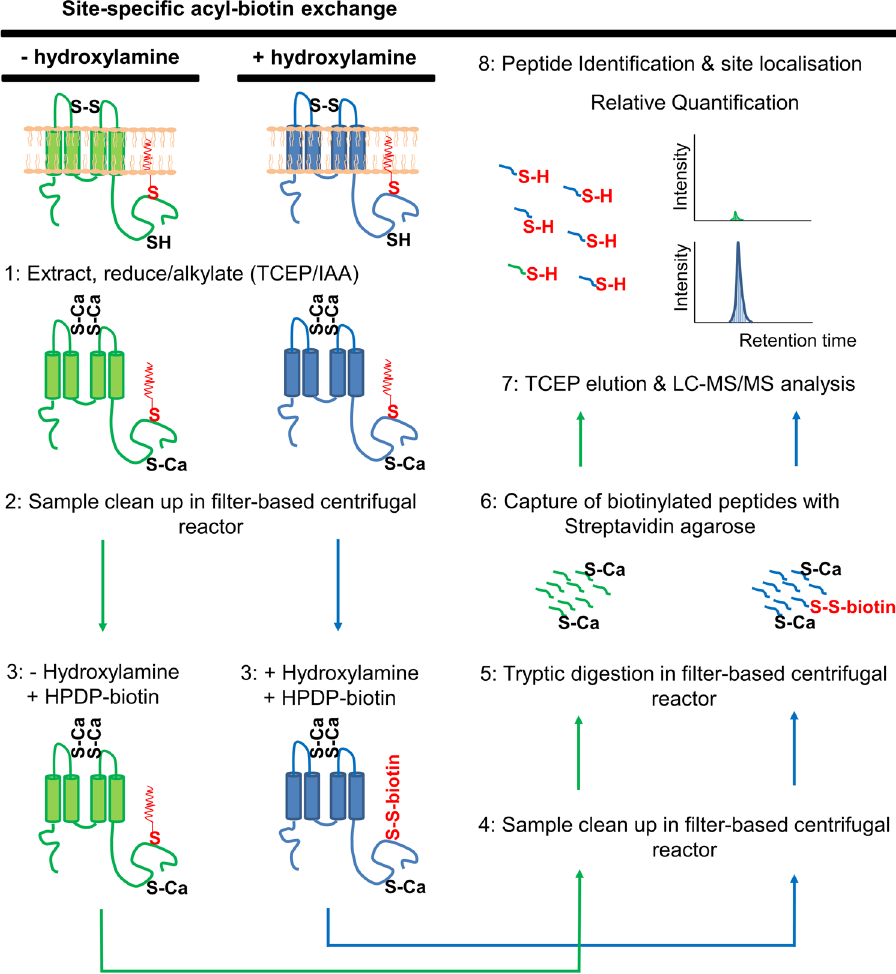
Figure 1. Schematic representation of the ssABE workflow. Protein samples are (1) reduced and alkylated and transferred to a filter-based centrifugal unit in which the following steps are performed; (2) rapid removal of reagents, (3) release of palmitoyl groups from proteins by hydroxylamine treatment at neutral pH and concomitant biotinylation of these newly “free” cysteine residues with a TCEP-cleavable biotin (HPDP-biotin) (4) rapid removal of reagents, followed by (5) digestion of proteins into peptides. (6) Biotinylated peptides are captured on Streptavidin agarose beads, washed and eluted (using TCEP) as free cysteine-containing peptides and (7) identified and quantified by LC-MS/MS analysis. Quantitative enrichment of peptides in + / − hydroxylamine treated samples allows identification of previously palmitoylated peptides. Palmitoylation sites are localized in peptide sequences by the presence of free (non-alkylated) cysteine